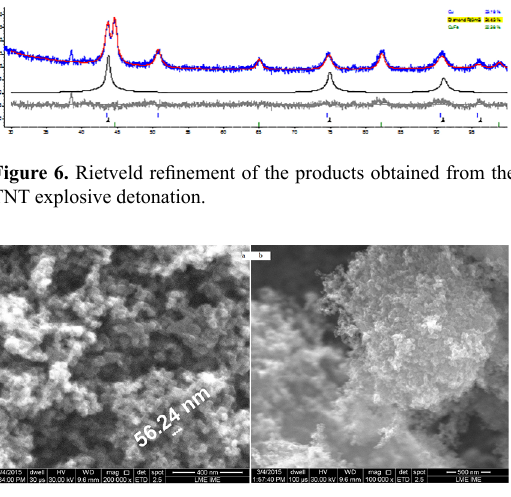
Figure 7. Micrographs of the nanodiamonds obtained by the detonation, at (a) 200,000X and (b) 100,000X.